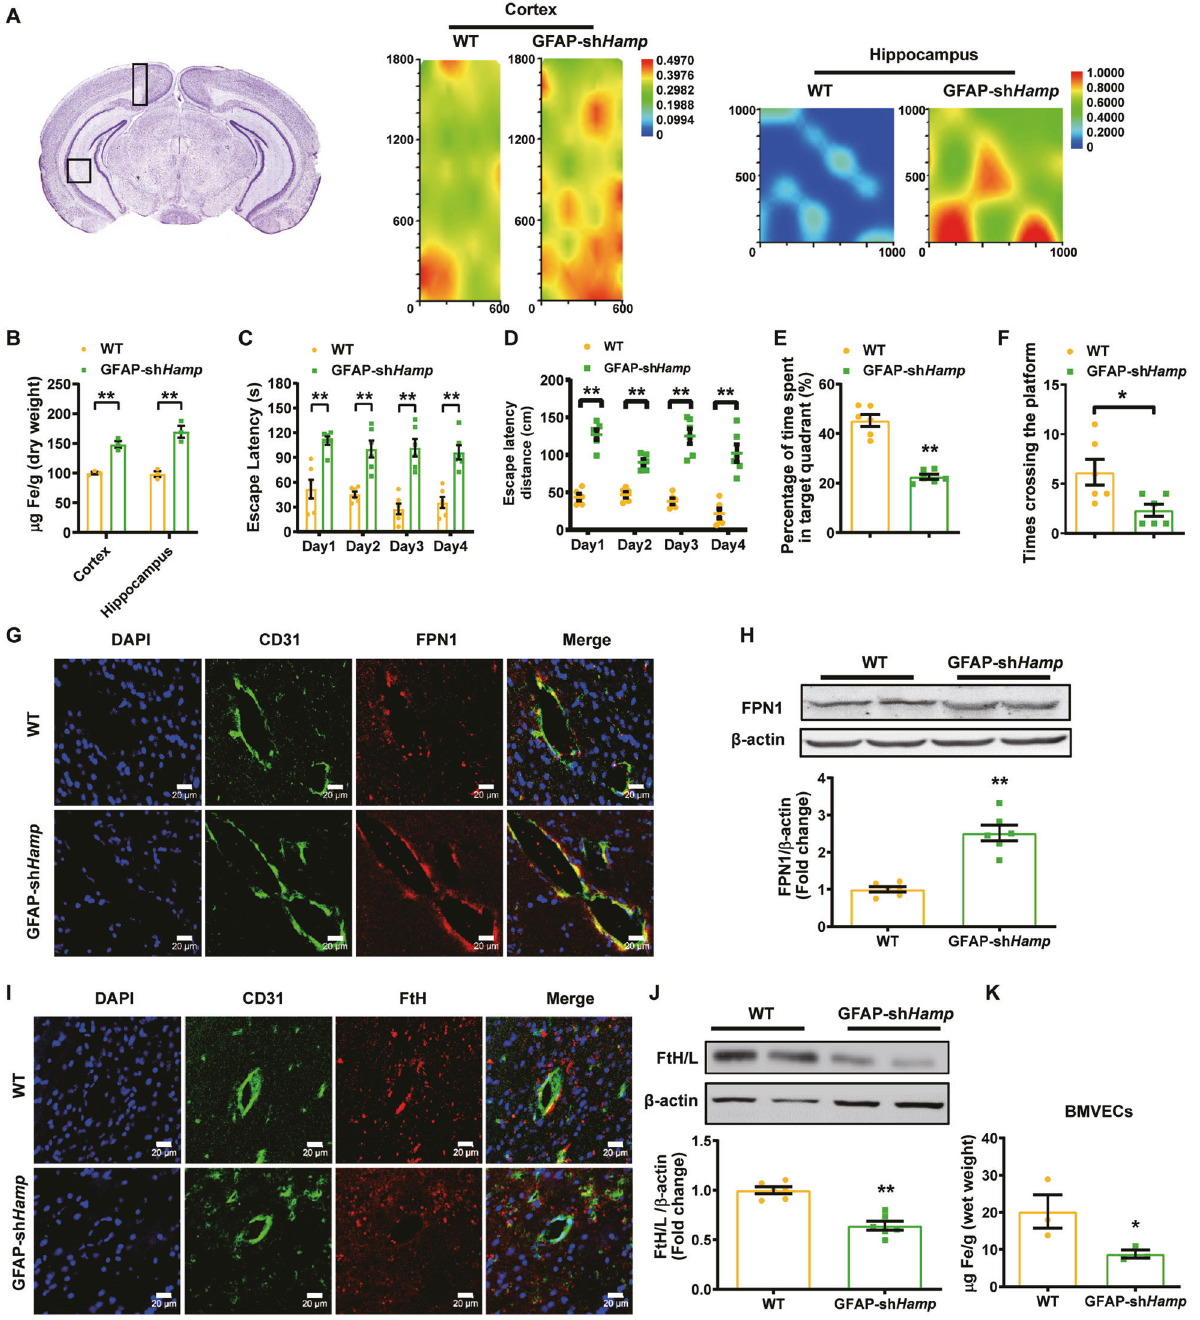
Fig. 1 Astrocyte hepcidin knockdown induced brain iron overload and cognitive decline whereas FPN1 increased in BMVECs. A is iron content in the cortex and hippocampus of 12-month-old GFAP-sh Hamp and WT mice measured by SR-XRF. Rectangles in the brain sections in the left panels indicate the areas scanned showing in the right-hand panels. B is total iron in the cortex and hippocampus of GFAP-sh Hamp and WT mice determined by ICP-MS. Data are presented as the mean ± SEM, n = 3, ** p < 0.01 GFAP-sh Hamp vs. WT group. C-F were GFAP- sh Hamp and WT mice subjected to a water maze test. The escape latency of time ( C ), path length ( D ), times of crossing the platform after removing the platform at the fi fth day ( E ) and percentage of time spent in target quadrant ( F ) are presented as the mean ± SEM, n = 6, * p < 0.05 and ** p < 0.01. G is immuno fl uorescent staining of CD31 (endothelial cell marker) and FPN1 in the brain of WT and GFAP-sh Hamp mice. Scale bar = 20 μ m. H is the level of FPN1 protein in BMVECs isolated from WT and GFAP-sh Hamp mice detected by western blot analysis. The relative expression levels were calculated after they were normalized to β -actin levels, and expressed as the mean ± SEM, n = 4 (WT) vs. n = 6 (GFAP-sh Hamp ), ** p < 0.01. I is immuno fl uorescent staining of CD31 and FtH in the brain in WT and GFAP-sh Hamp mice. Scale bar = 20 μ m. J is the level of ferritin protein in BMVECs. The relative expression levels were calculated after they were normalized to β -actin levels and expressed as the mean ± SEM, n = 4 (WT) vs. n = 6 (GFAP-sh Hamp ), ** p < 0.01 vs. WT group. K is iron in BMVECs isolated from WT and GFAP-sh Hamp mice detected by ICP-MS. Data are presented as the mean ± SEM, n = 3, * p < 0.05 vs. WT group.